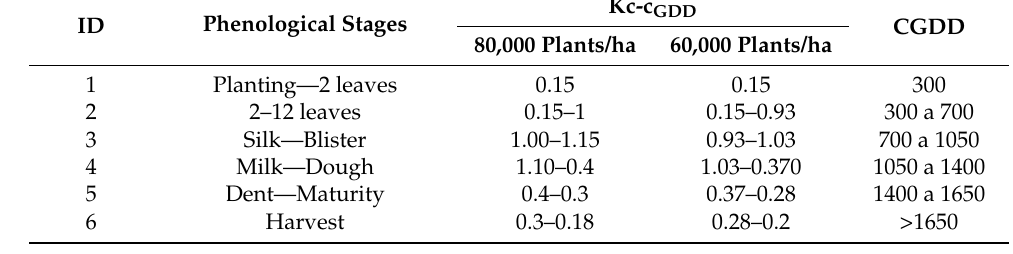
Table 4. Estimated crop coefficient values (Kc-c GDD ) for phenological stages and two density plants.